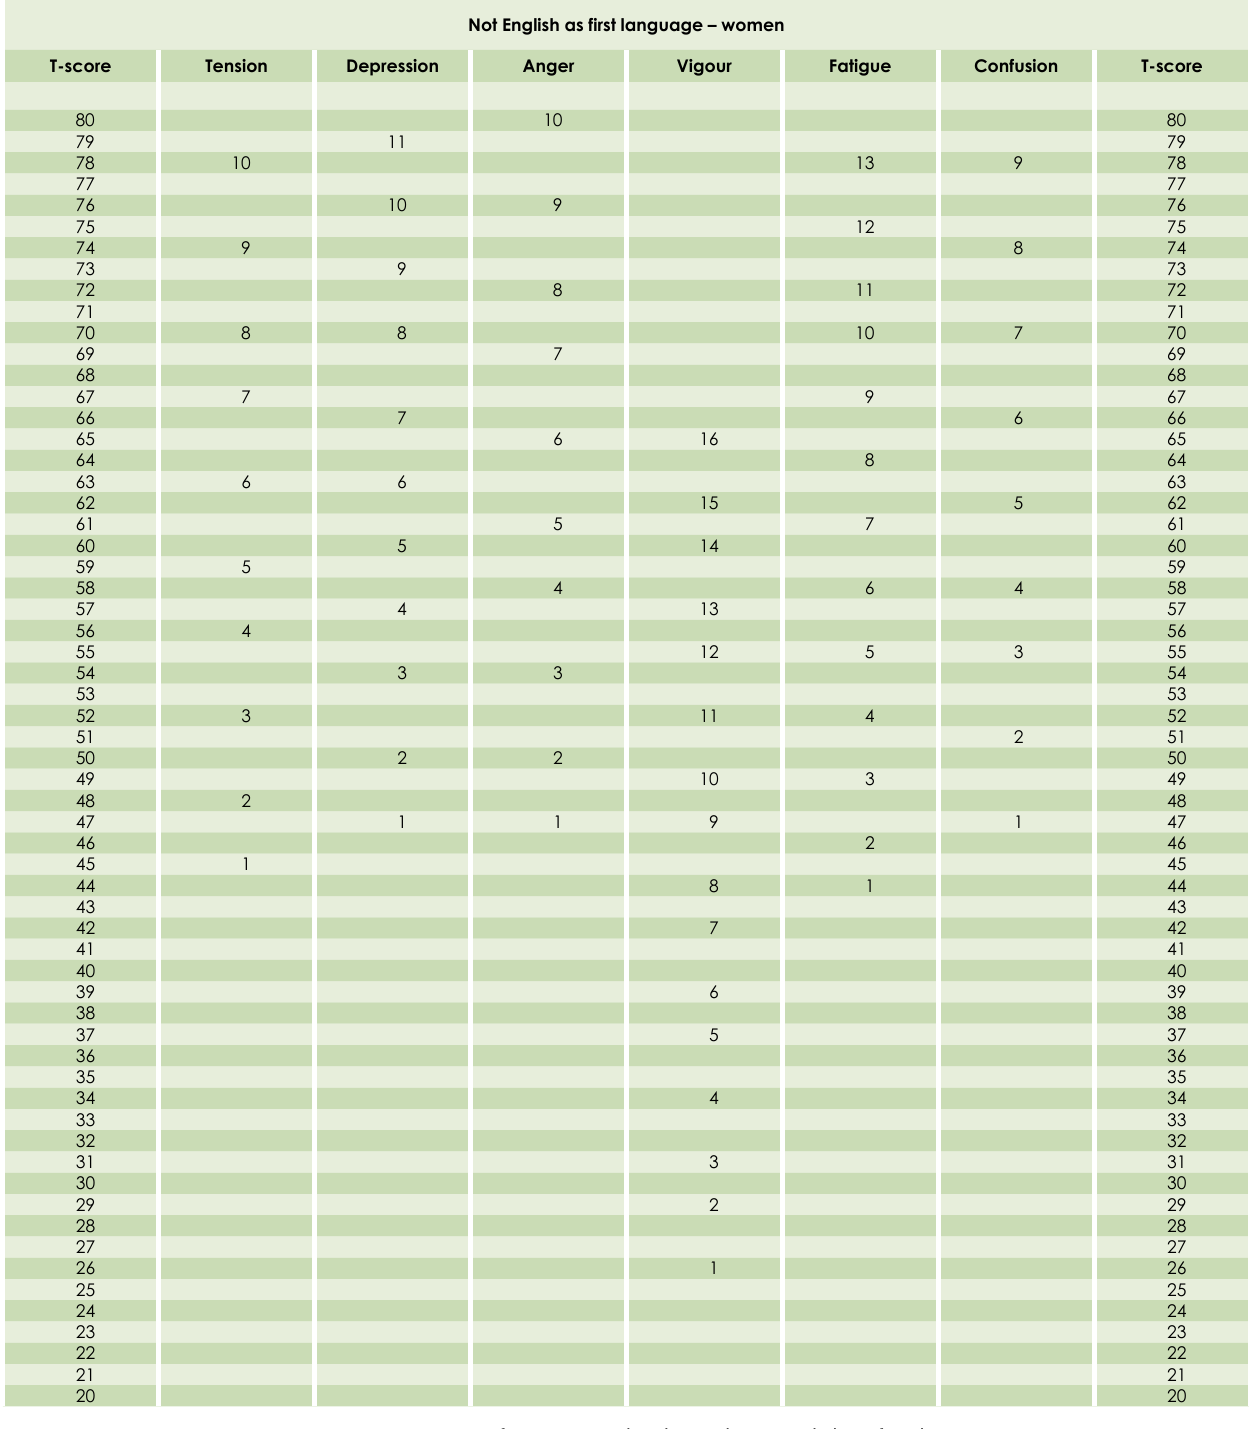
Fig. 3. BRUMS T-scores for women who do not have English as first